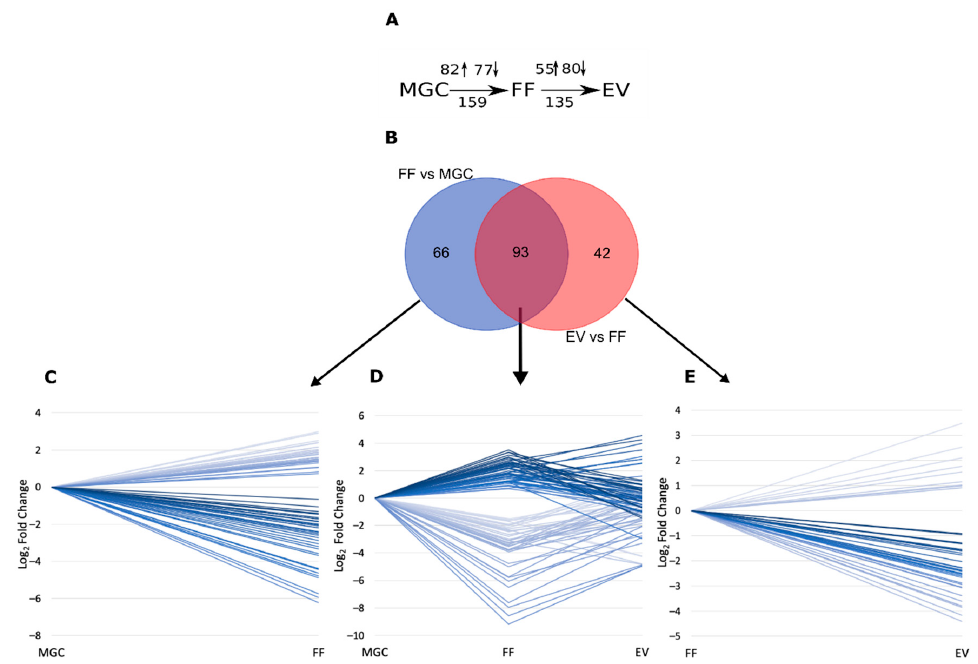
Figure 5. Comparison of cellular and cell-free miRNA expression levels. ( A ) Schematic representation of miRNA expression level comparisons performed between sample types and the number of di ff erentially expressed (DE) results obtained. Arrows depict the number of upregulated ( ↑ ) or downregulated ( ↓ ) genes in each comparison. ( B ) Number of distinct and shared DE miRNAs between comparisons. ( C ) DE results unique to FF vs. MGC comparisons ( D ) DE results common for FF vs. MGC and EV vs. FF comparisons. ( E ) DE results unique to EV vs. FF comparisons. Each line in panels ( C – E ) depicts the statistically significant (FDR < 0.05) expression level di ff erence between sample types of one miRNA. EV—extracellular vesicles, FF—cell-free follicular fluid, MGC – mural granulosa cells.